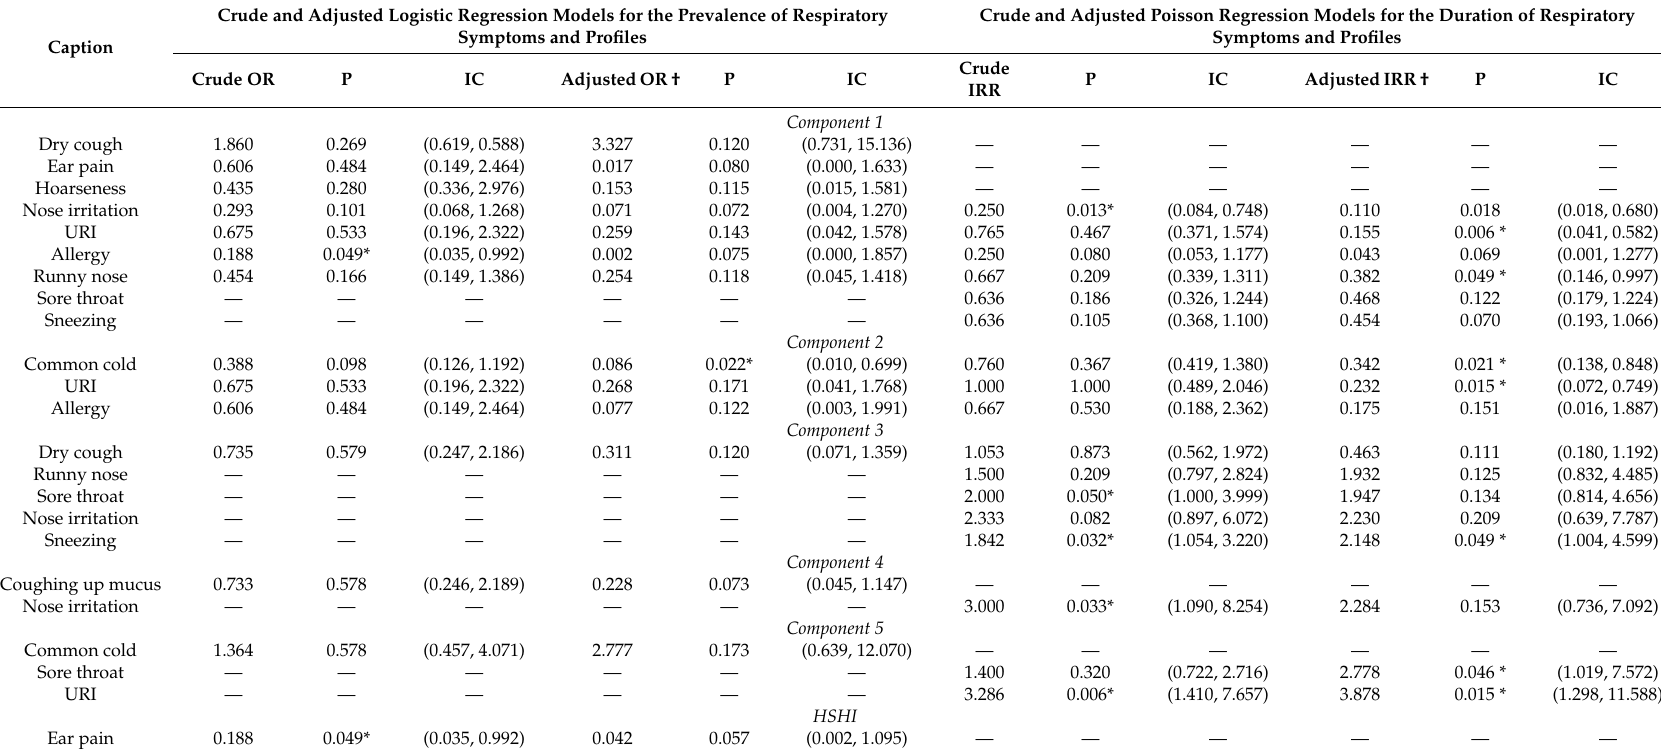
Table 4. Selected crude and adjusted association measures between HSHI and symptoms frequency ( n =